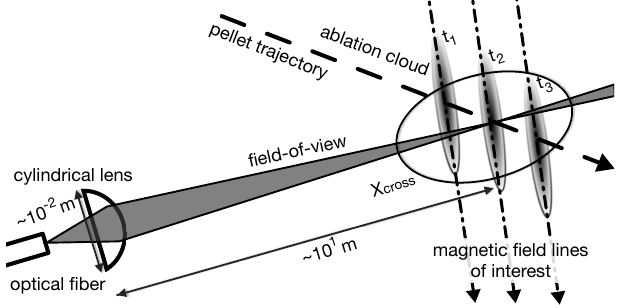
Figure 2. Unscaled representation of the optical concept of the observation